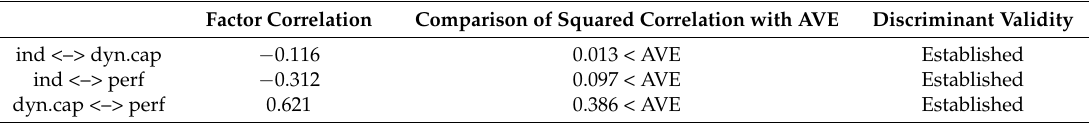
Table 5. Discriminant validity.